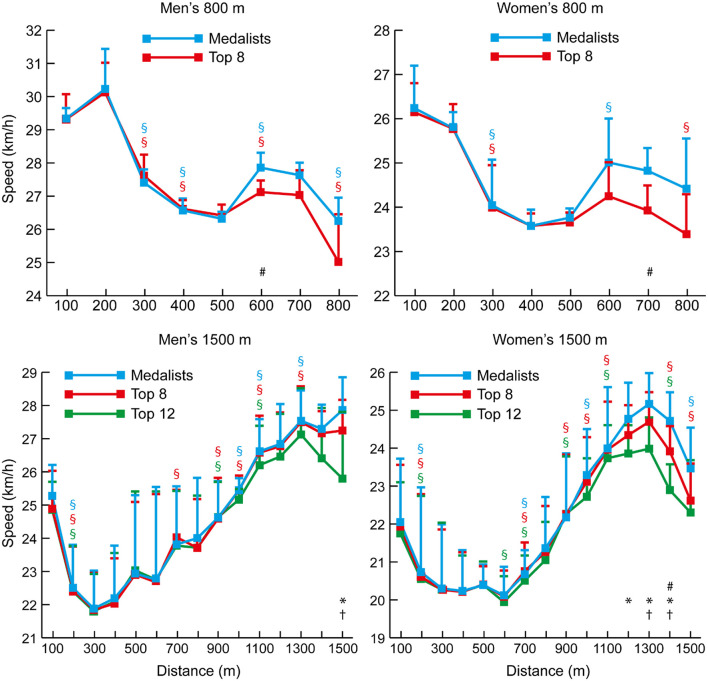
The mean (+ SD) 100-m segment speed for each group of men and women 800 and 1,500 m athletes. Differences between successive segments (p < 0.05, d ≥ 0.61) are represented by § (blue for medalists, red for Top 8, and green for Top 12). Differences in segment speed between groups (p < 0.05, d ≥ 0.61) have been annotated for medalists vs. Top 8 (#), medalists vs. Top 12 (1,500 m only) (*), and Top 8 vs. Top 12 (1,500 m only) (†).